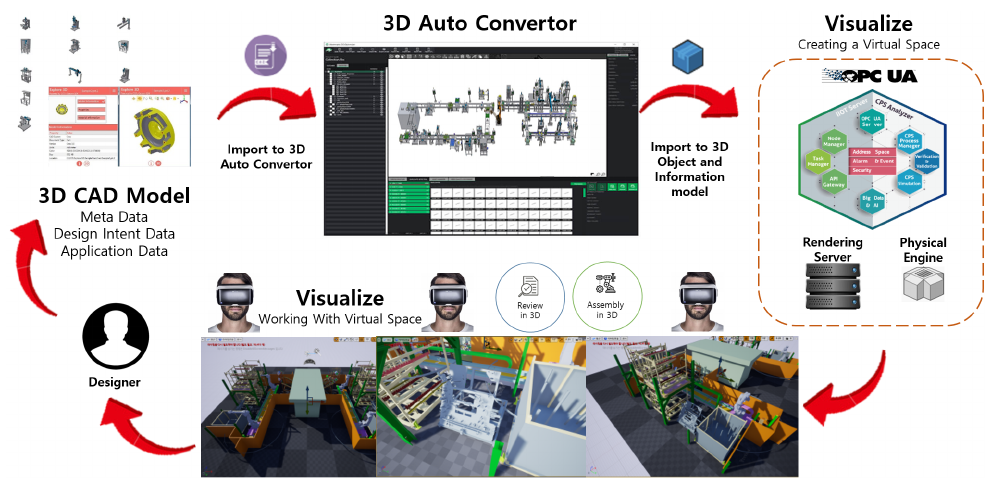
Figure 5. Model separation from 3D design